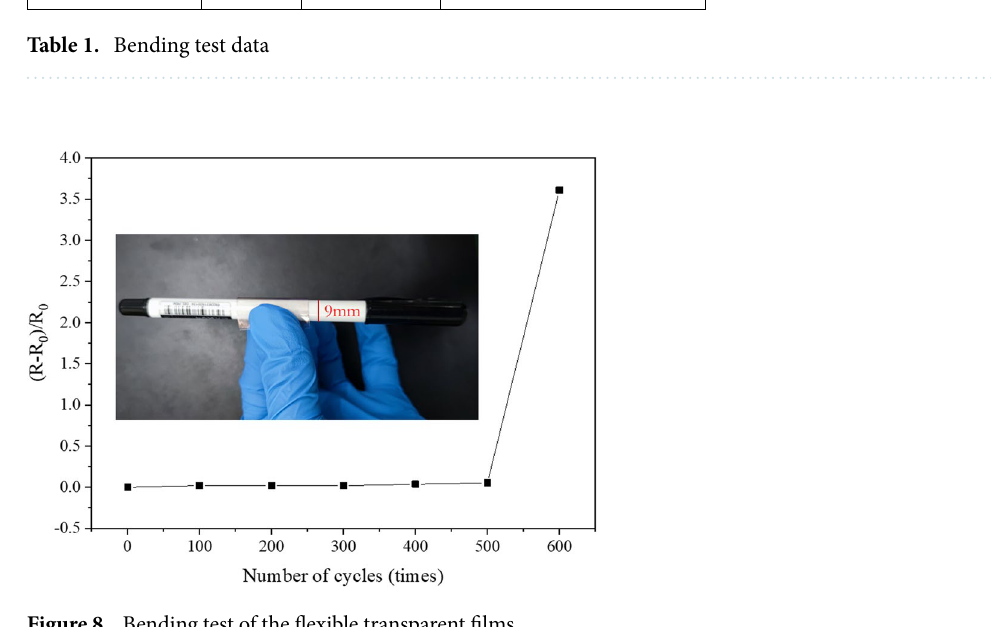
Figure 8. Bending test of the flexible transparent